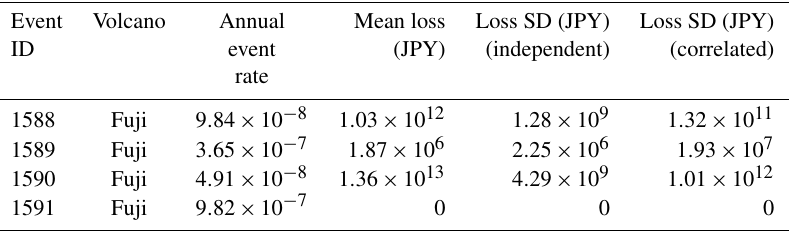
Table 5. Subset of ELT outputs from the volcano risk model, with the run of the residential portfolio described. The table shows losses on the portfolio caused by four of the model’s ash fall events from Mt Fuji. The mean loss and the standard deviation of the loss distribution associated with each event (in JPY) are reported in the ELT.